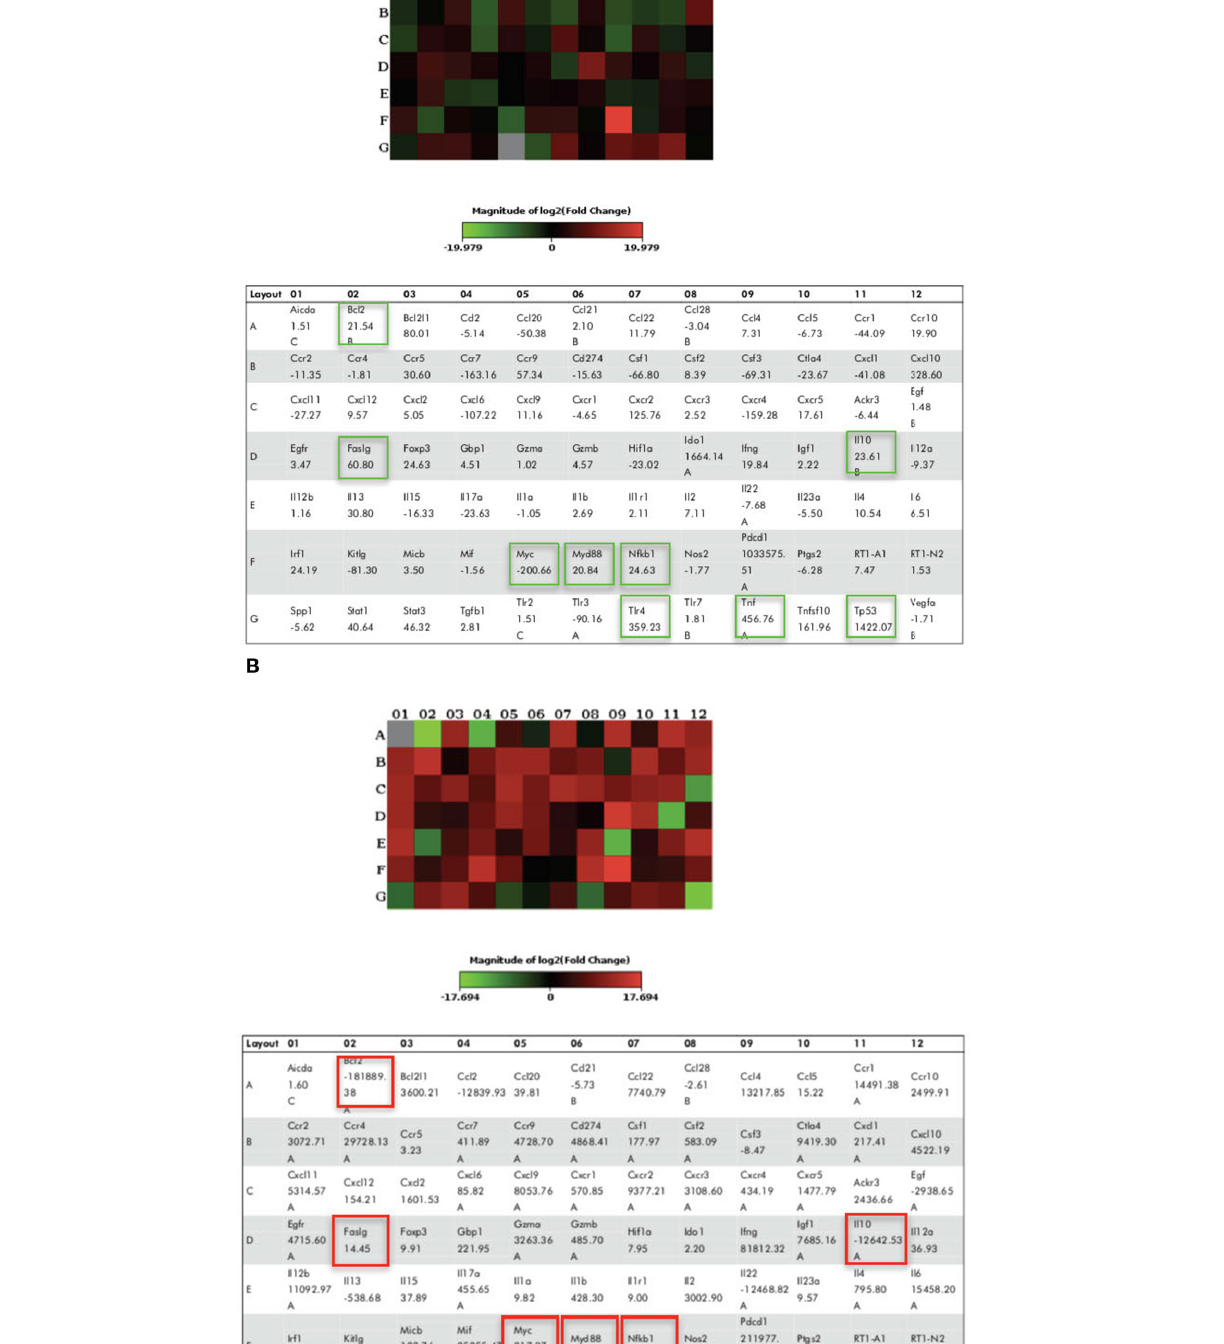
Frontiers in Cellular Neuroscience |